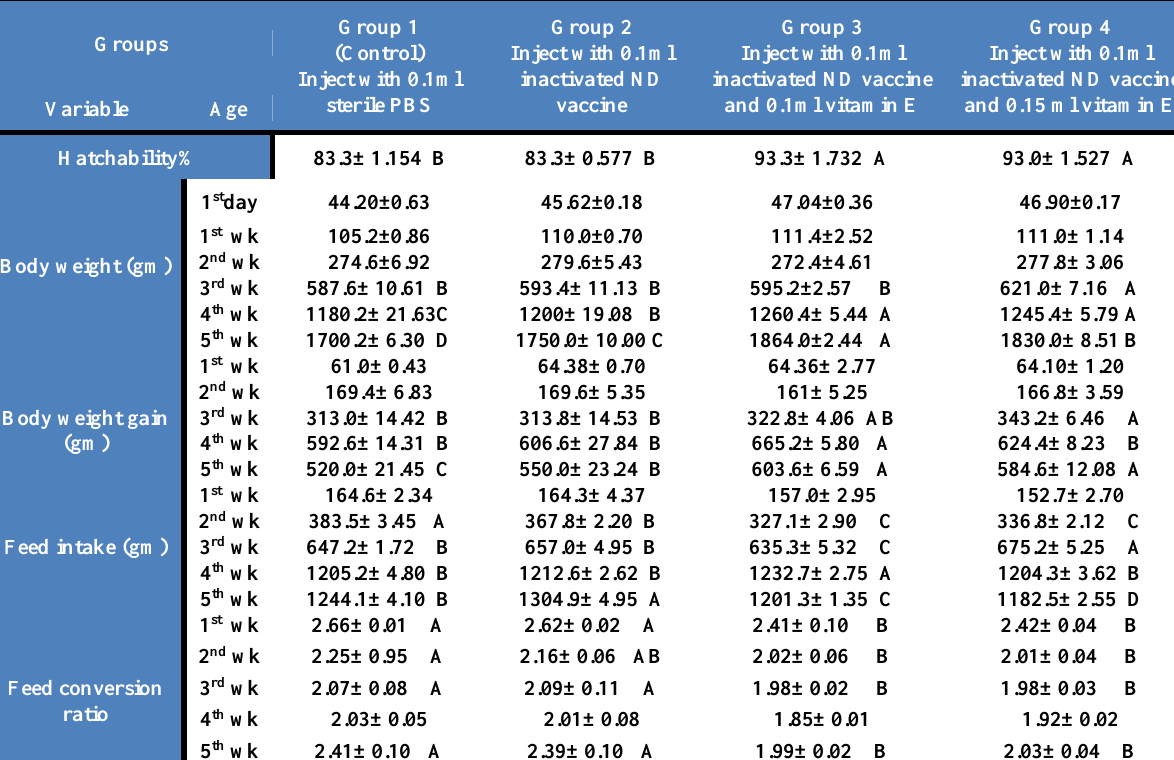
Table, 1: Effect of vitamin E in hatchability, body weight, body weight gain, feed intake and feed conversion ratio for different groups. (Mean ± Standard